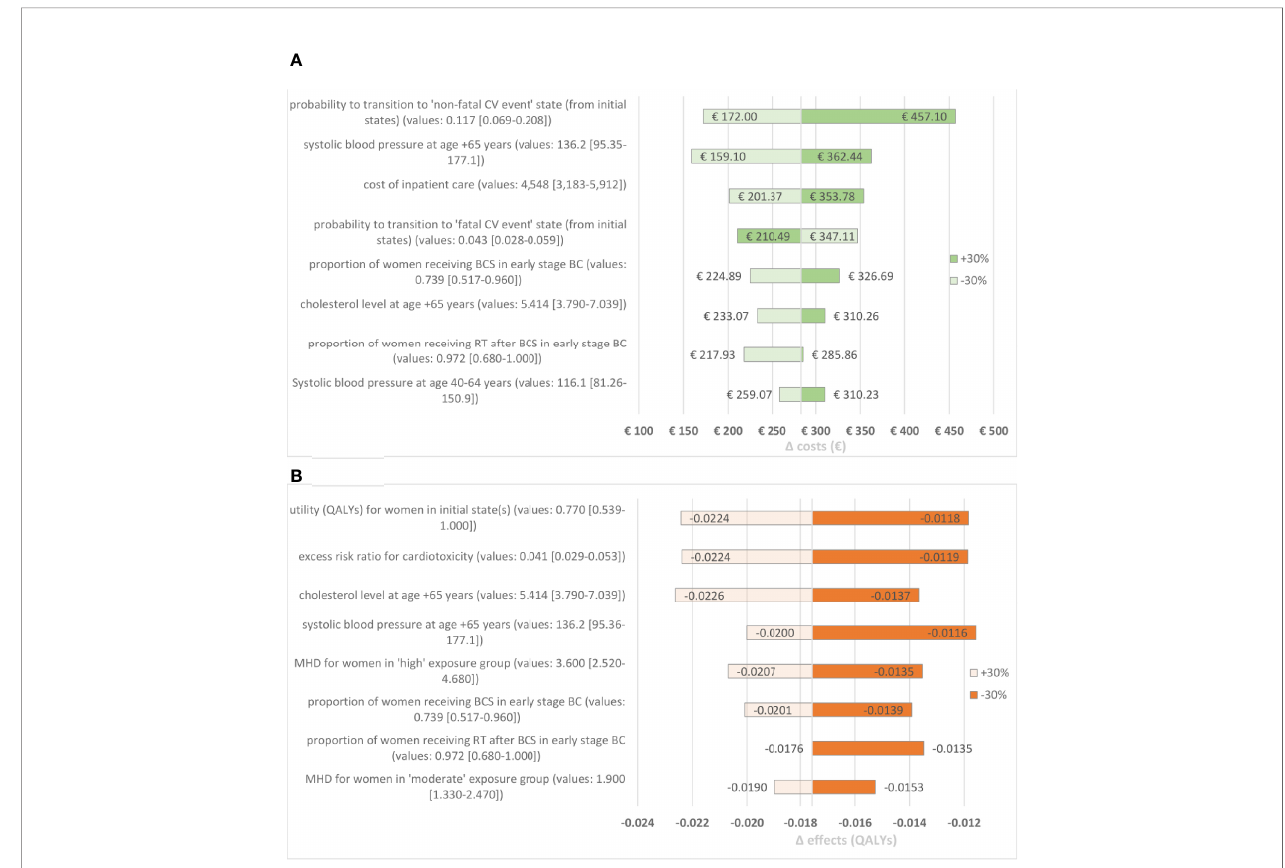
FIGURE 4 | (A) Tornado diagram for costs. This diagram represent the impact on incremental costs when setting the parameter to 70% and 130% of the base case value. The 8 most in fl uential parameters are presented. (B) Tornado diagram for QALYs. This diagram represent the impact on incremental QALYs when setting the parameter to 70% and 130% of the base case value. The 8 most in fl uential parameters are presented. BC, Breast Cancer; BCS, Breast Conserving Surgery; CV, Cardiovascular; MAS, Mastectomy; MHD, Mean Heart Dose; QALYs, Quality Adjusted Life